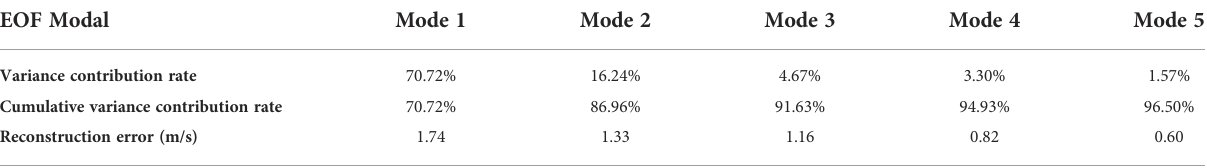
TABLE 1 Variance contribution rate and error of the 1st-to-5th-order EOFs reconstruction. EOF Modal